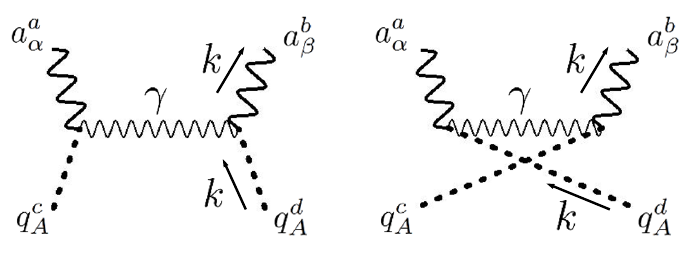
D E A a A b Q c Q d (cid:11) A A (cid:12)